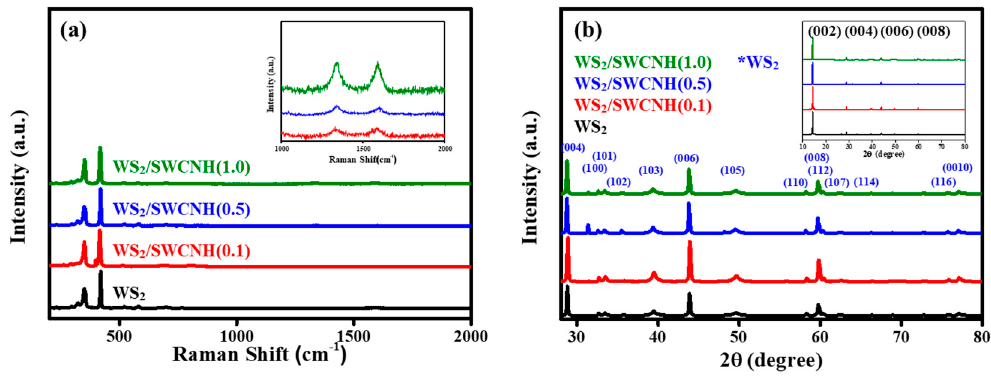
Figure 5. ( a ) Raman spectra and ( b ) x-ray diffraction (XRD) patterns of the as-sintered WS 2 and WS 2 / SWCNH nanocomposites. Insets show the respective magnified graphs.